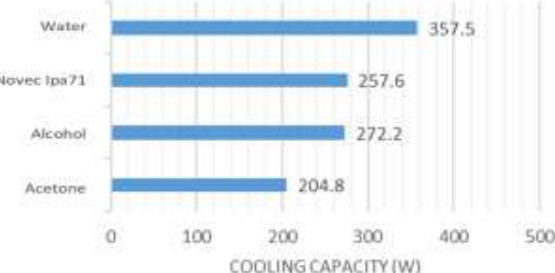
Fig. 9. Comparison of cooling capacity, load 500 W, volume 80 %.